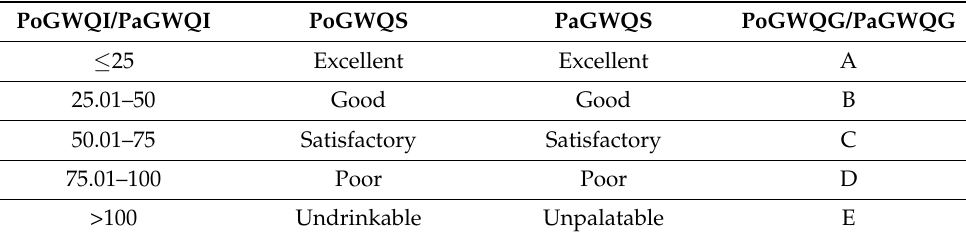
Table 1. Identification of potability and palatability groundwater quality statuses (PoGWQSs, PaG- WQSs), and grades (PoGWQGs, and PaGWQGs)